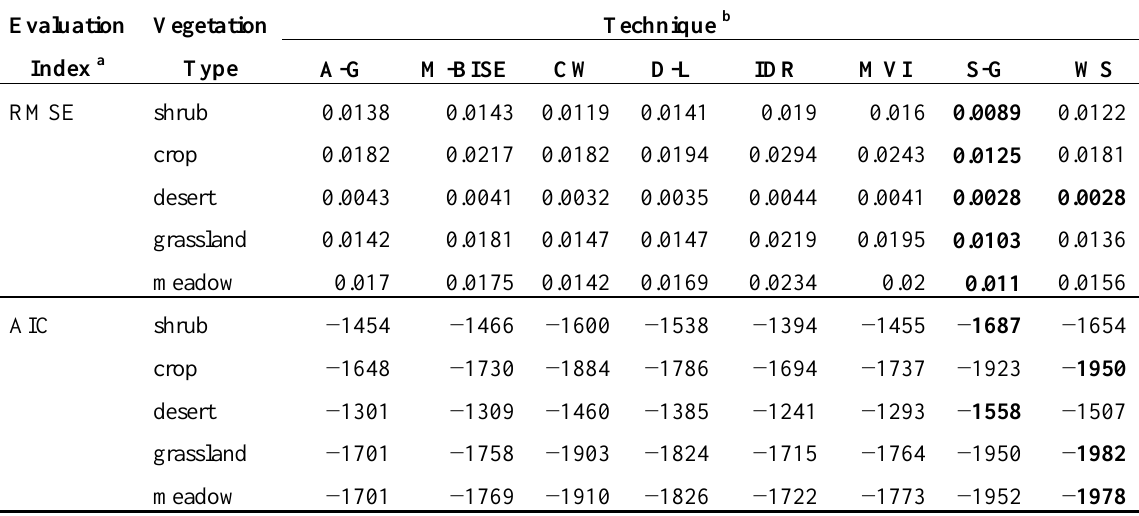
Table 6. RMSE, AIC, and BIC values for the eight techniques for the NDVI time-series data of Terra MOD13A2 from February 2000 to February 2013 (best-fitting technique shown in